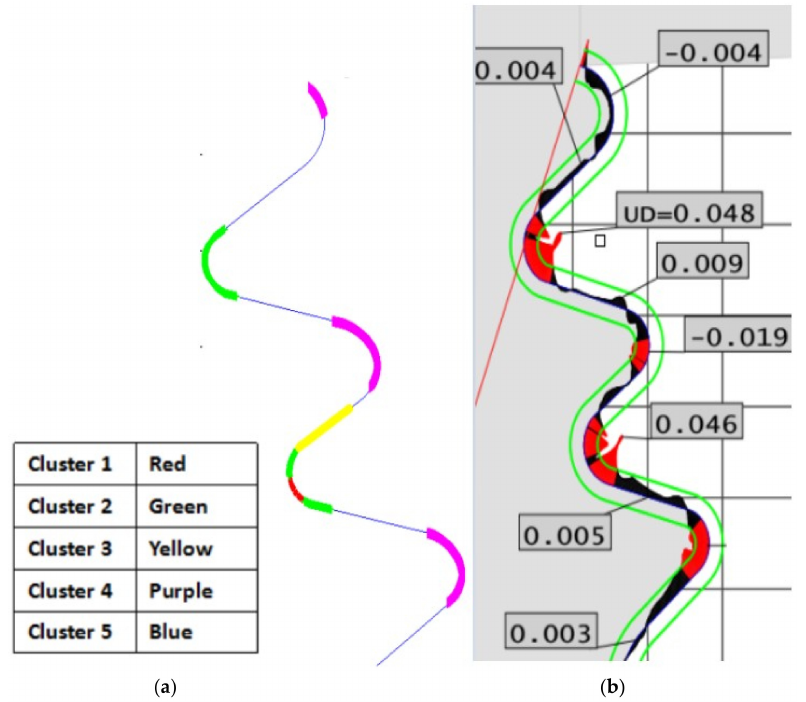
Figure 9. ( a ) Graphical representation of the clusters provided by hierarchical clustering; ( b ) Geometry of the error throughout the fir-tree profile, as measured by the